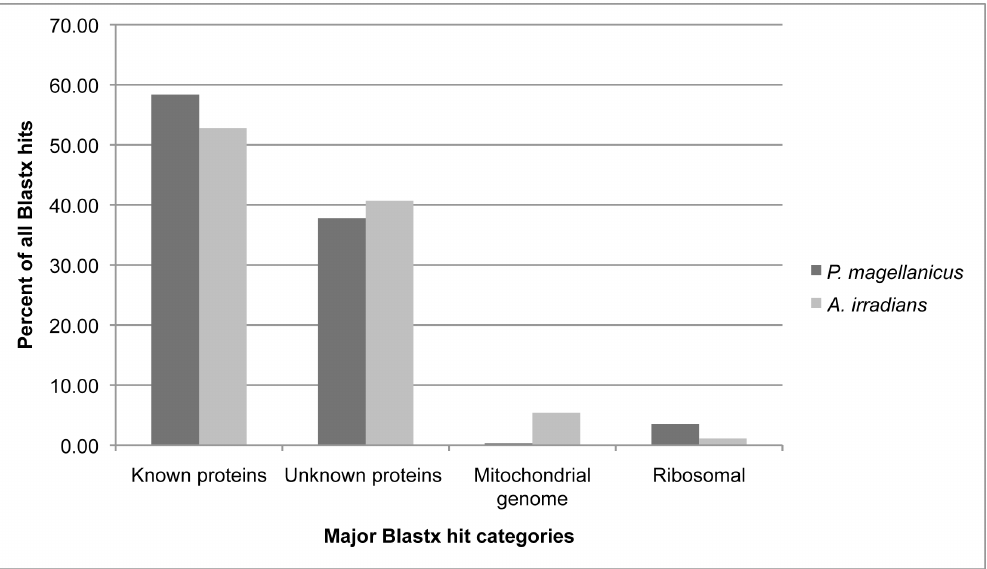
Figure 3. Scallop BLAST hit distributions. Percent hits in each major category of proteins examined (‘‘Known’’=annotated nuclear proteins; ‘‘Unknown’’=proteins described as putative, hypothetical, unknown, or a species mRNA clone; ‘‘Mitochondrial genome’’=annotated mitochondrial proteins; ‘‘Ribosomal’’=ribosomal genes).